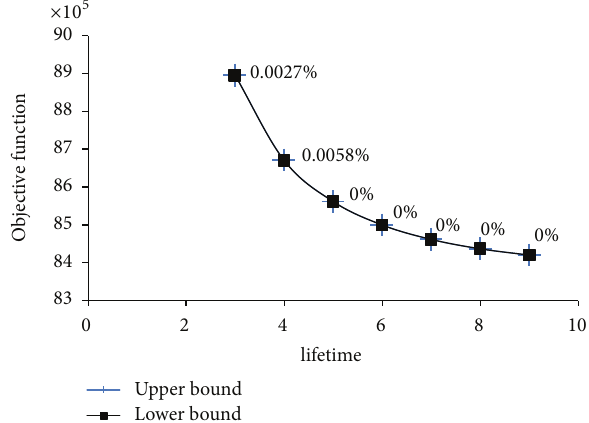
Figure 8: Sensitivity of objective function to changes in variances of demands for 15-node data set.